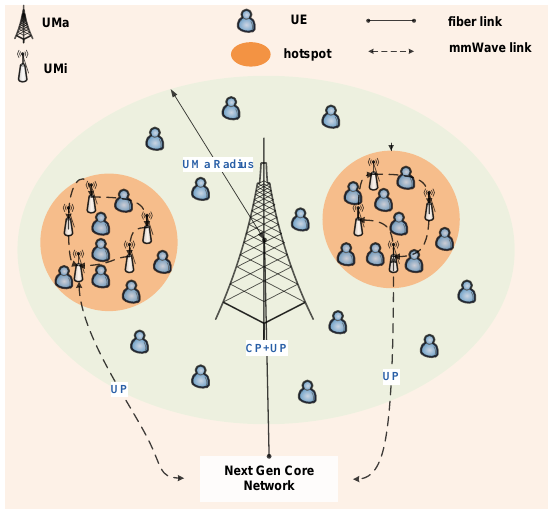
Figure 1. Millimeter wave (MmWav)e network model architecture. UE: User equipment; UP: User plan; CP: Control plan; UMa: Macro base station (BS); UMi: Micro BS.